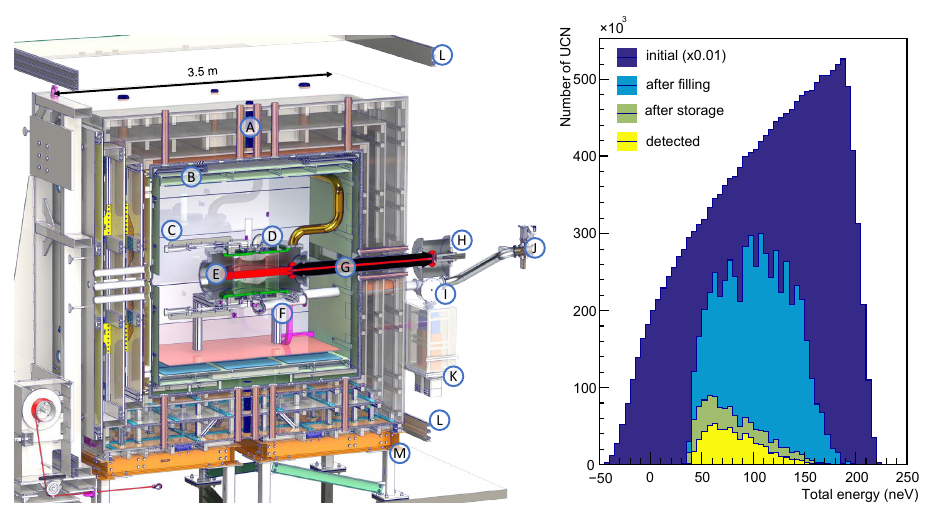
Figure 3. Left : Cutaway view of the 3D model for the TUCAN EDM Apparatus. (A) 4-layer magnet- ically shielded room, (B) Self-shielded B 0 coil, (C) EDM cell valve actuation, (D) EDM cell shutter, (E) Central high-voltage electrode, (F) UCN guide, (G) High-voltage feeder, (H) High-voltage vacuum feed through, (I) EDM detector switch, (J) UCN and vacuum valve, (K) Spin analyzers and detectors, (L) Coil compensating the ambient magnetic field, (M) Support structure. Right : Spectra of kinetic energy plus gravitational potential energy of UCNs determined by Monte Carlo simulations using PEN- Track [20]. The initial spectrum produced in the source is scaled by a factor of 0.01 in the